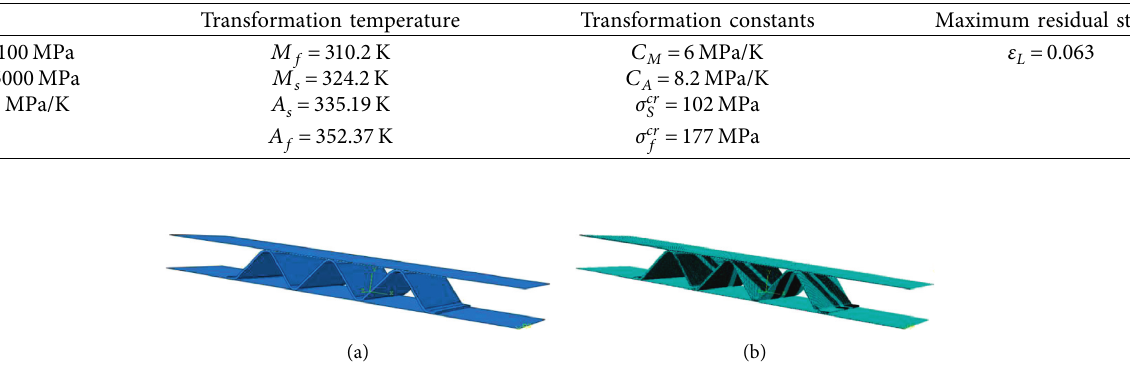
Figure 12: Finite element model of the SMA corrugation experiment. (a) Geometric model. (b) Mesh